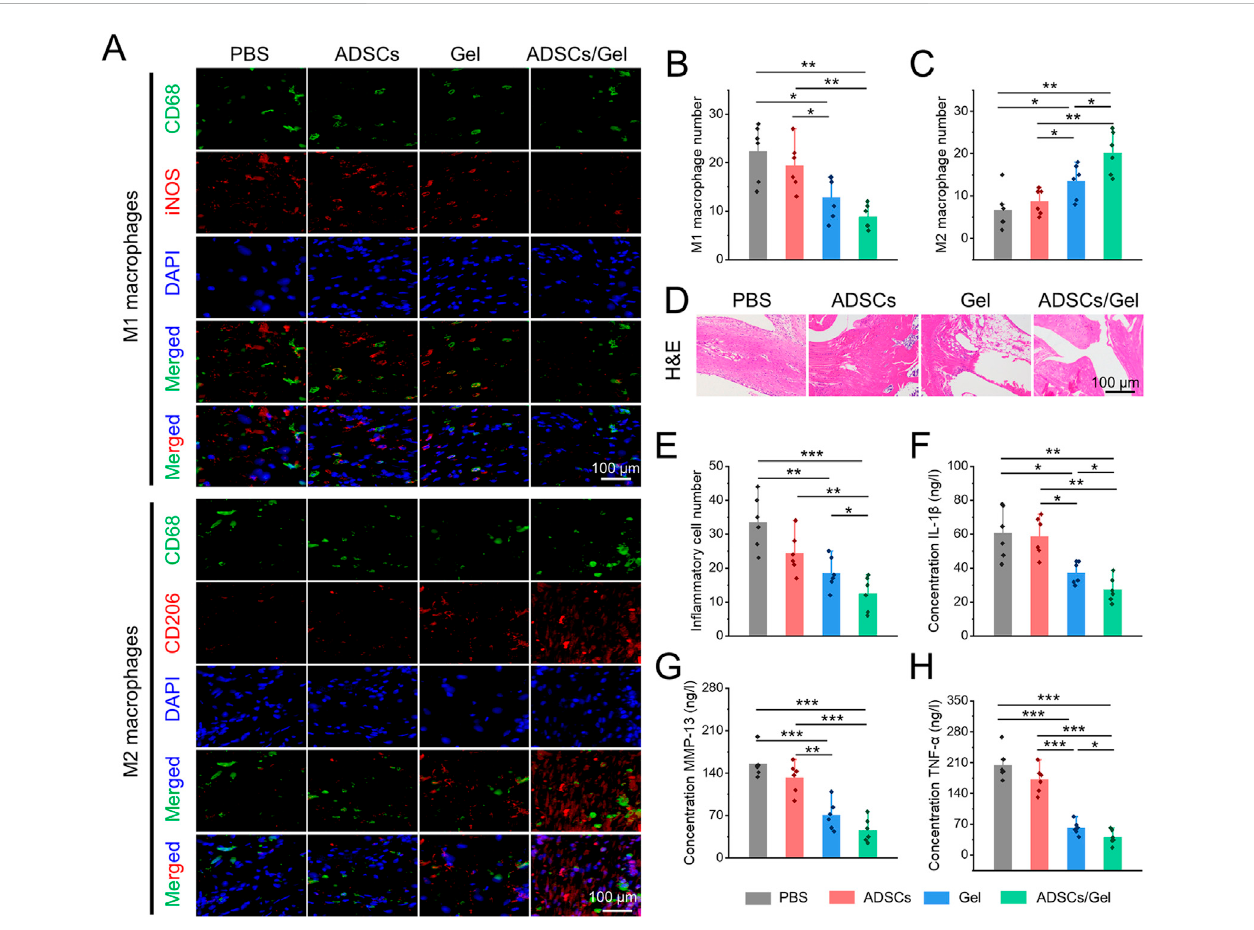
FIGURE 7 Intra-articular injection of ADSCs loaded HA-EGCG hydrogel induced synovial macrophages polarization and alleviated synovitis. (A) Immuno fl uorescence of CD68 plus iNOS to co-label M1 macrophages and CD68 plus CD163 to co-label M2 macrophages. (B) Quantitative analysis of the number of M1 macrophages per fi eld ( n = 6). (C) Quantitative analysis of the number of M2 macrophages per fi eld ( n = 6). (D) H&E staining of synovial tissues. (E) Quantitativeanalysisofthenumberofin fl ammatorycells in fi ltrationinsynovial tissues( n =6). (F – H) Theconcentrationsofvariouspro-in fl ammatory cytokines, including IL-1 β , MMP-13, and TNF- α in synovial tissues by ELISA ( n = 6) (* p < 0.05, ** p < 0.01, and *** p <